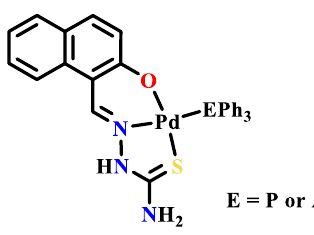
Figure 30. Two palladium(II) complexes of naphthylhydrazone with thiourea side chain with PPh 3 and AsPh 3 co-ligands, reported by R. Prabhakaran’s research